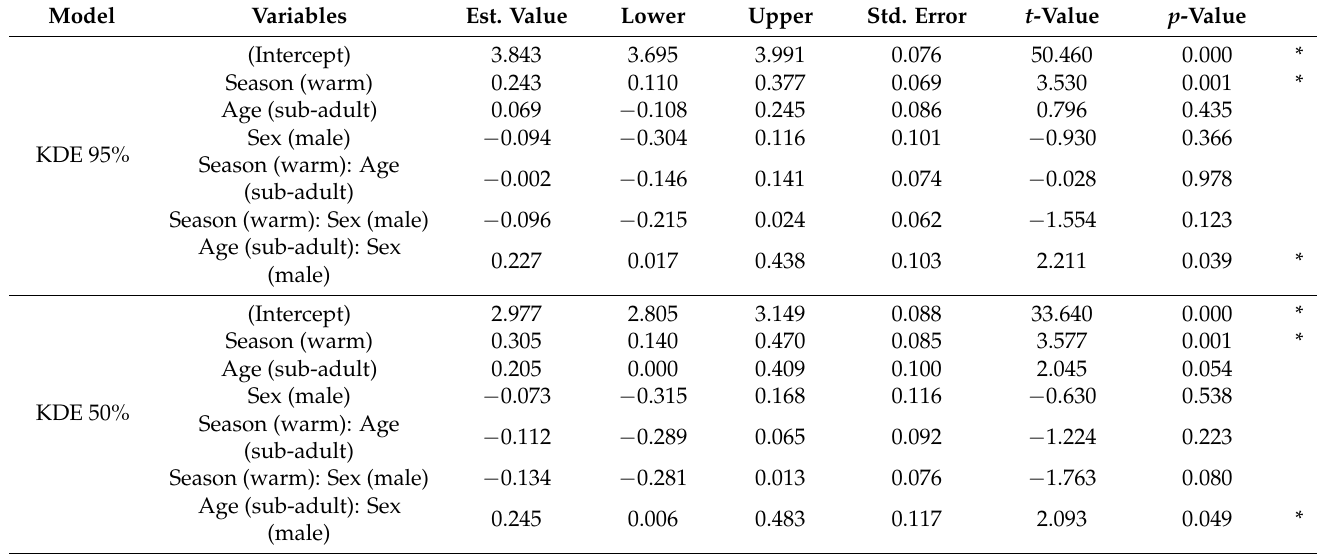
Table 1. Linear mixed models that evaluate how the home range size Kernel Density Estimator (KDE) of 95% and 50% of the contour areas of immature Andean condor individuals can be affected by age (juvenile or sub-adult), sex, season (warm or cold) and the interactions between these variables. The asterisks show statistically significant